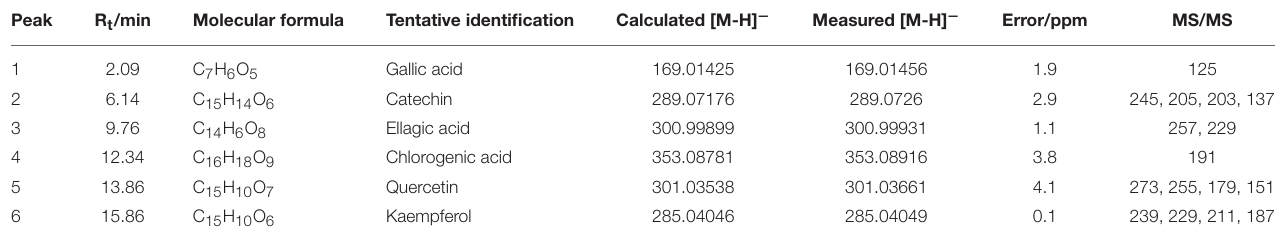
TABLE 5 | Mass spectrometric data of the six compounds identified in the dichloromethane fraction of Camellia nitidissima Chi flowers by HPLC Triple TOF MS/MS. Peak R t /min Molecular